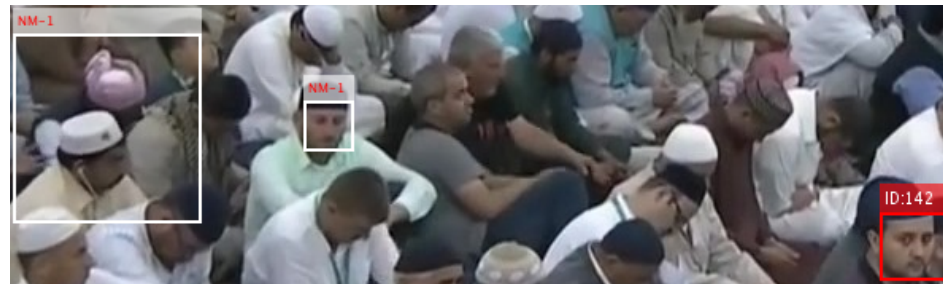
Figure 10. Prediction after maturity by soft-voting.